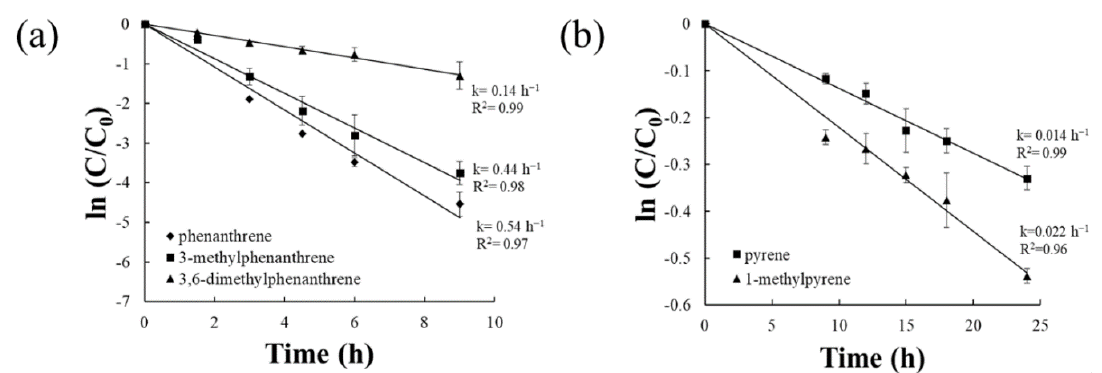
Figure 1. First-order kinetic fits of biodegradation experiments for ( a ) phenanthrene, 3-methylphenanthrene, and 3,6-dimethylphenanthrene, and ( b ) pyrene and 1-methylpyrene with the obtained rate constants (k). Error bars denote standard errors of triplicate analysis.